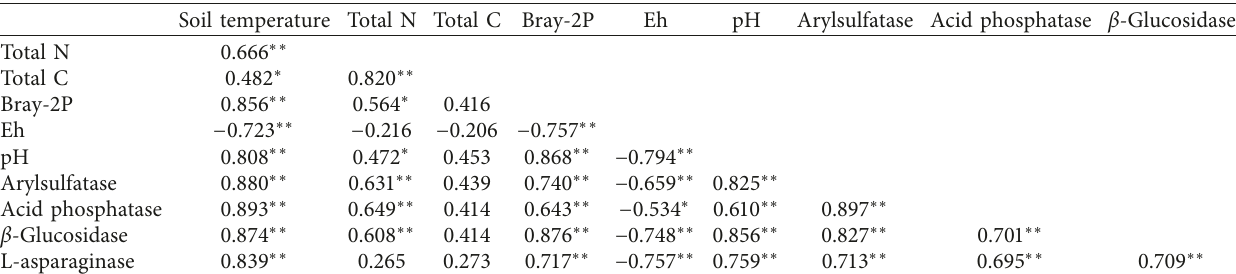
Figure 3: Relationships between soil temperature and enzyme activity in paddy soil. (a) Acid phosphatase; (b) L-asparaginase; (c) arylsulfatase; (d) β -D-glucosidase. Table 1: Spearman rank correlation coefficients between soil properties and enzyme